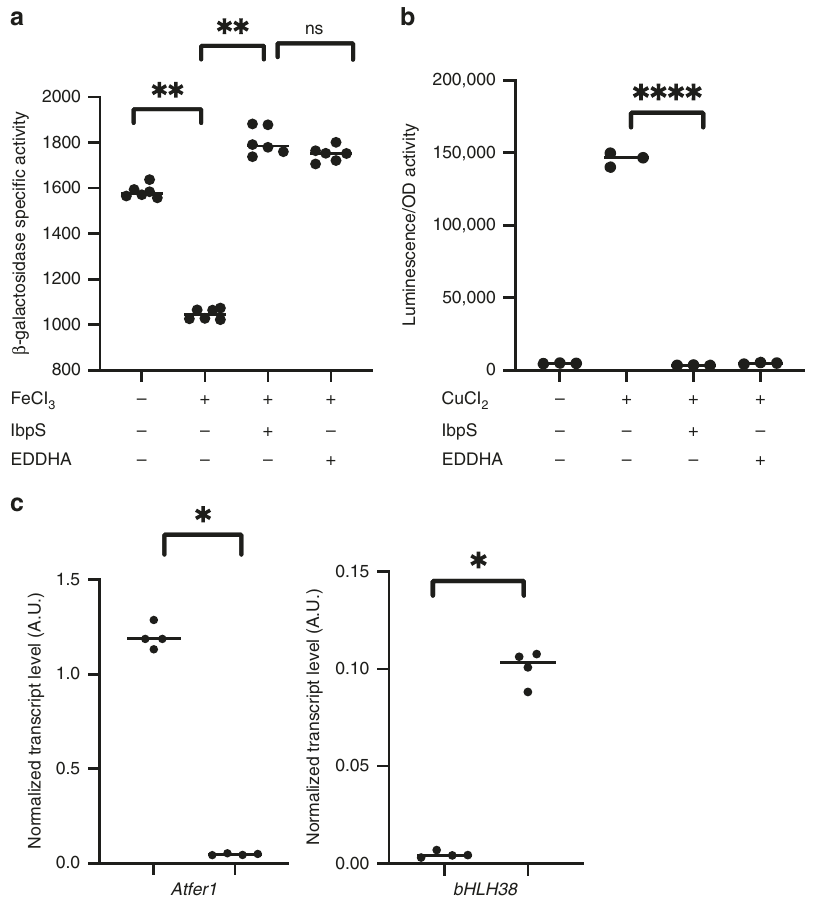
Fig. 7 Modi fi cation of the intracellular metal concentration by extracellularly added IbpS. a D. dadantii strain A6050 containing the acsA-lacZ fusion was grown overnight in low phosphate + glycerol medium either supplemented or not with 2 µ M FeCl 3 , 20 µ M IbpS, or 2 µ M EDDHA. β -galactosidase activity was measured with o -nitrophenyl- β - D -galactose. The activities are expressed in µ moles of o -nitrophenol produced per minute and per milligram of bacterial dry weight + standard deviation. Data are expressed as the mean ( n = 6) from six independent experiments. ns indicates non signi fi cative